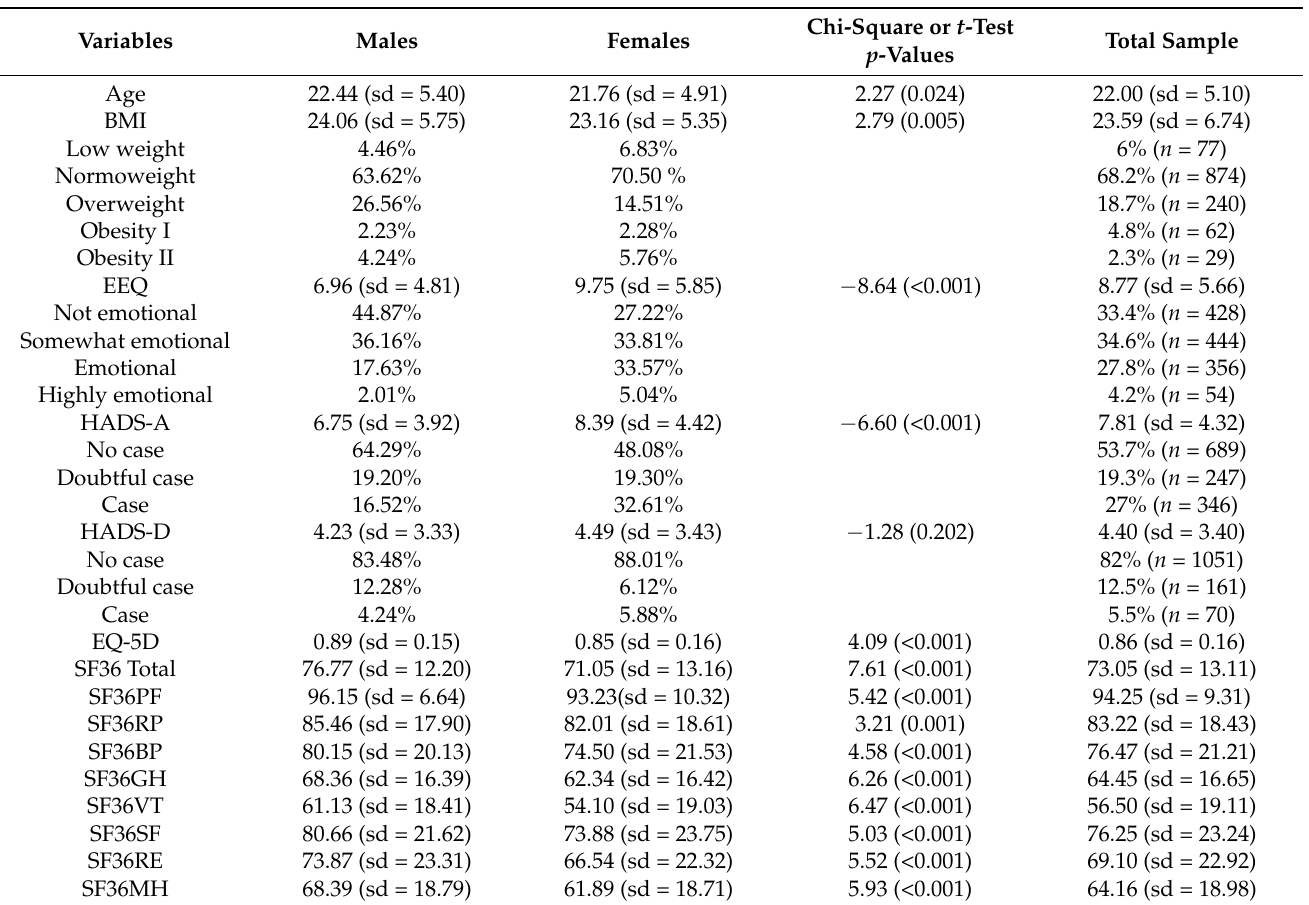
Table 1. Description of the studied sample.